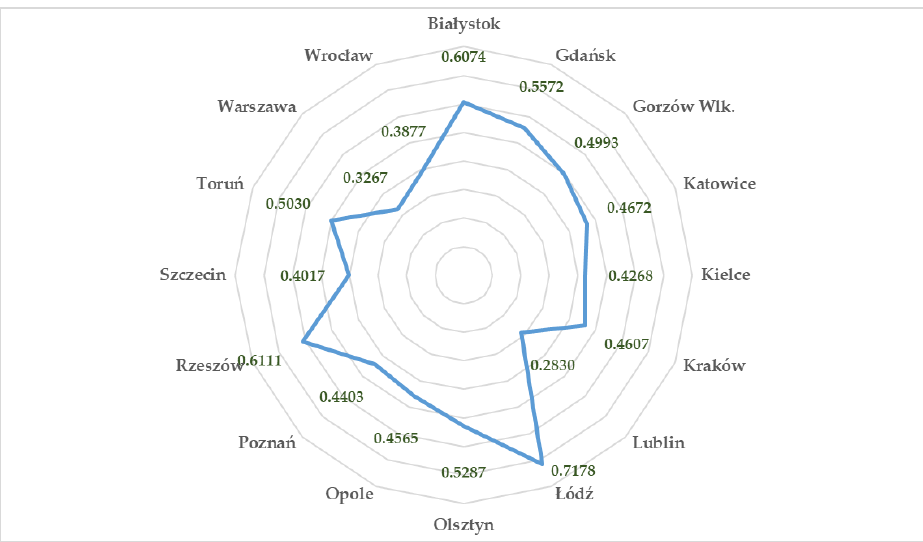
Figure 3. Aggregate results of multi-criteria analysis for the analyzed cities.